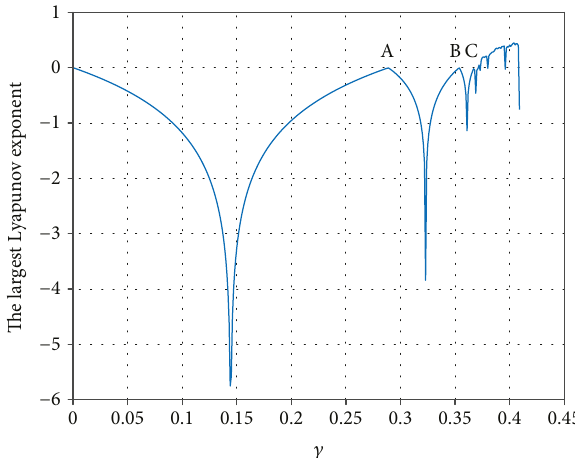
Figure 4: Largest Lyapunov exponent in situation